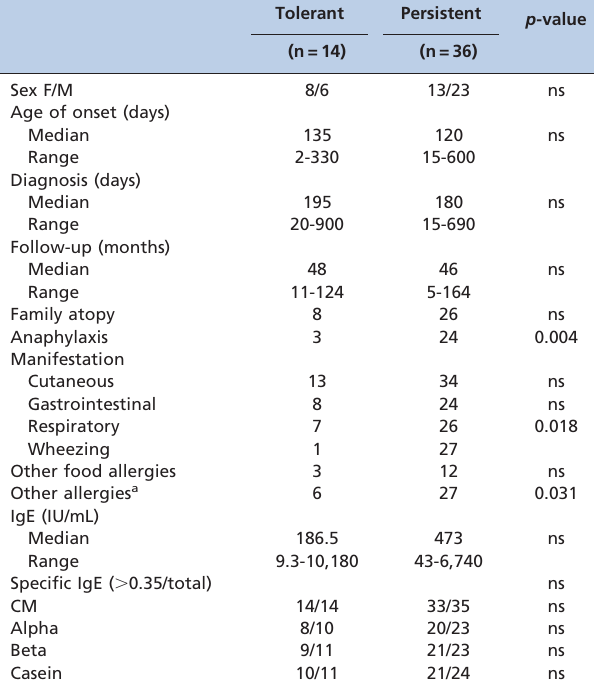
Table 1 - Clinical and laboratory characteristics of patients with persistent or tolerant, IgE-mediated cow’s milk